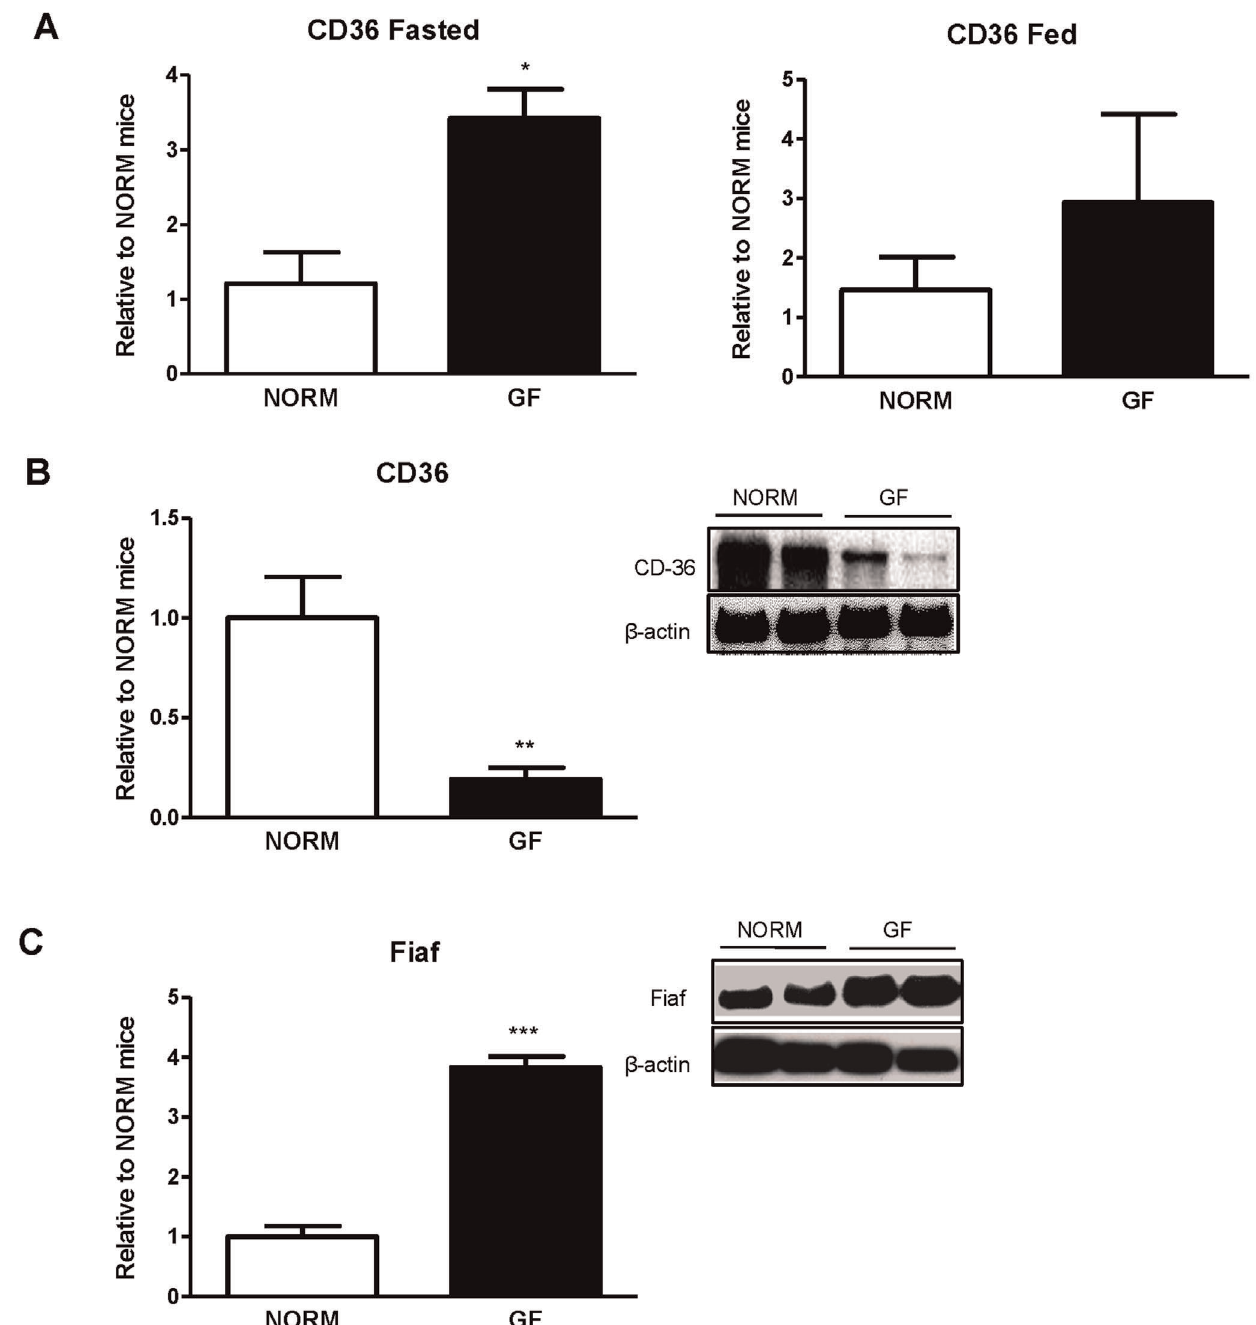
Figure 2. Gene expression of (A) lingual CD36, and protein expression of (B) intestinal CD36, and (C) intestinal FIAF. (A) GF mice exhibited 3-fold up-regulation of lingual CD36 mRNA in the posterior lingual epithelium relative to NORM mice during fasting. GF mice displayed a slight, but non-significant, increase in lingual CD36 expression following intralipid exposure. (B) Intestinal CD36 was significantly down-regulated in GF compared to NORM mice. (C) Intestinal FIAF expression was increased over 3-fold in GF relative to NORM mice Data are expressed as means 6 SEM. *P , 0.05, **P , 0.01, ***P , 0.001, compared to NORM.